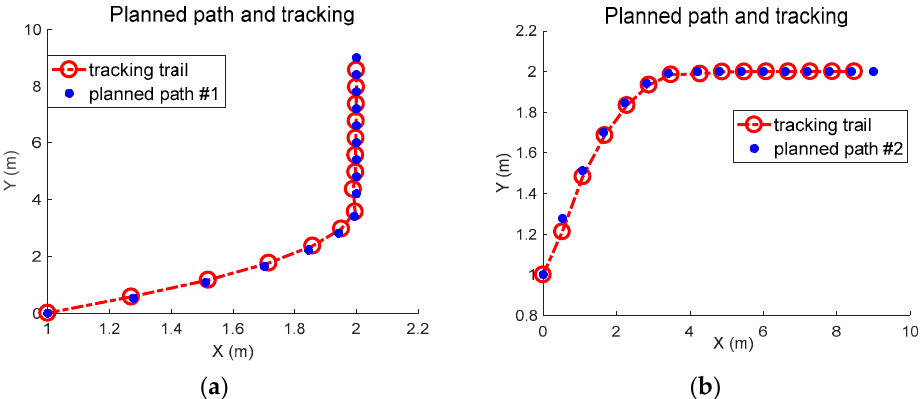
Figure 7. Path tracking results using optimized BP Neutral Network. ( a ) The differences between the planned positions along path #1 and the real positions during tracking; ( b ) The differences between the planned positions along path #2 and the real positions during tracking.